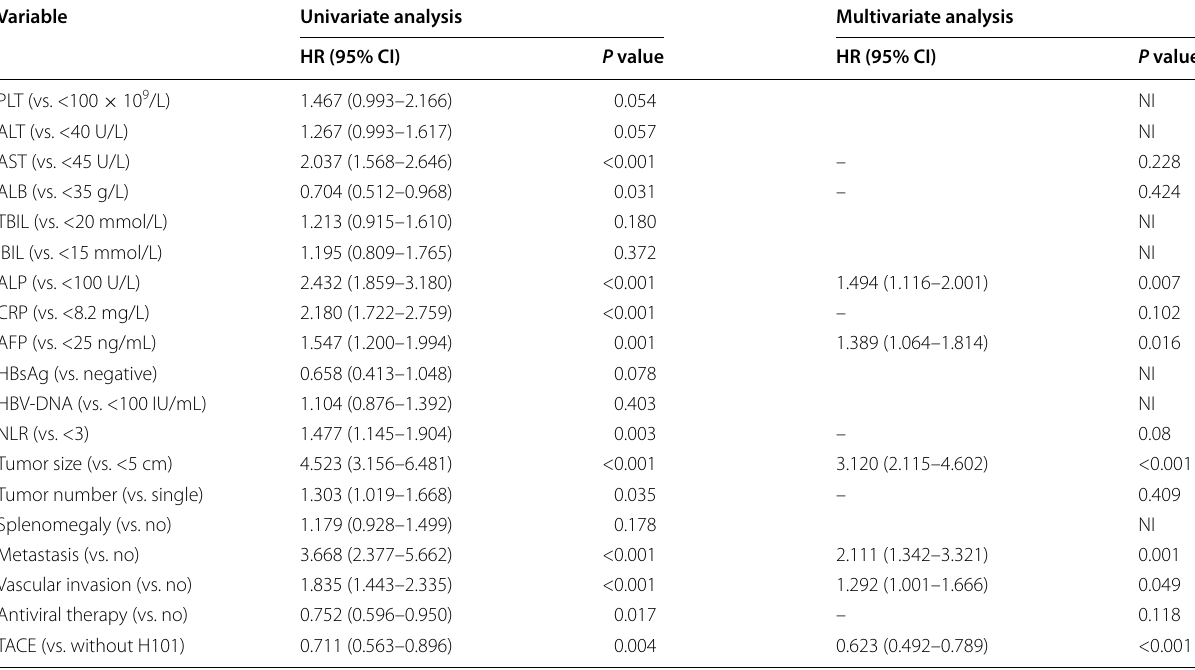
HR hazard ratio, CI confidence interval, NI not included. Other abbreviations as in Table